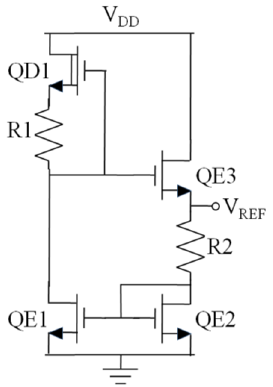
Figure 2. GaN voltage reference based on Wilson current mirror [30].